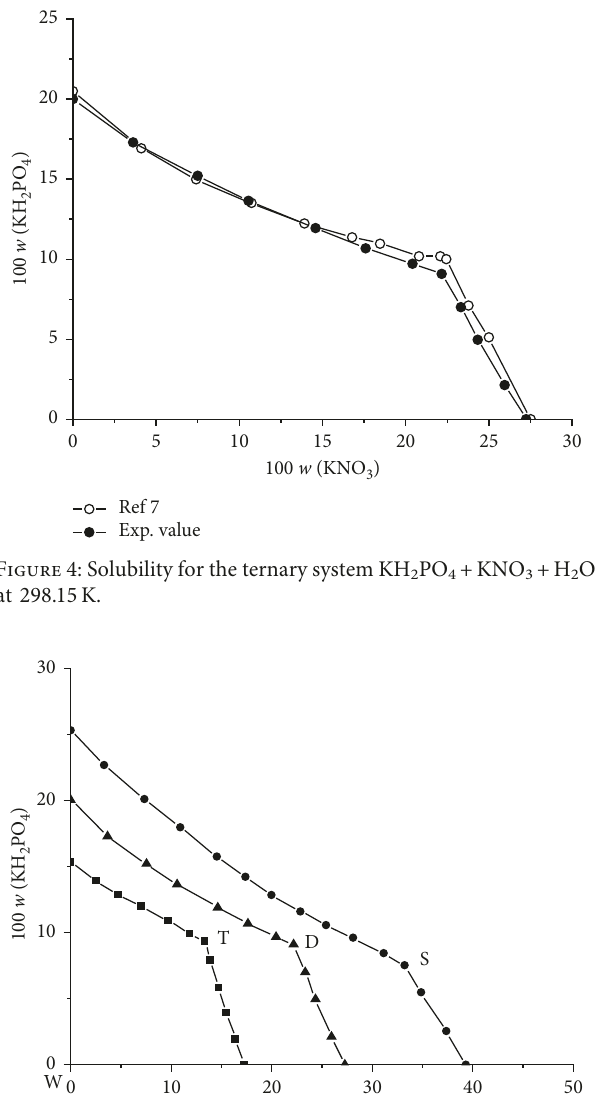
2 PO 4 +KNO 3 +H 2 O